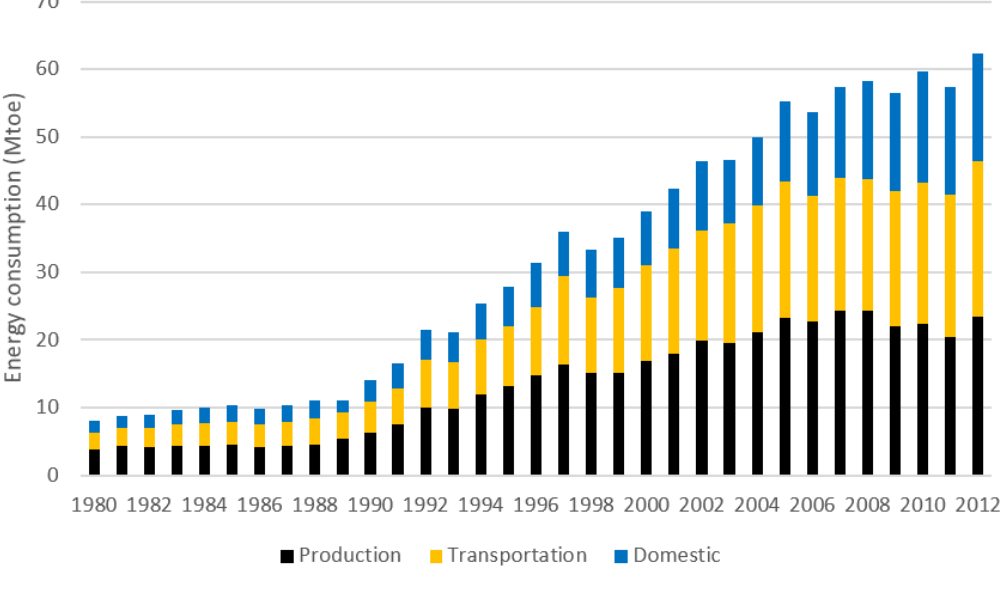
Figure 17. Energy consumption of Malaysia expressed by sectors.